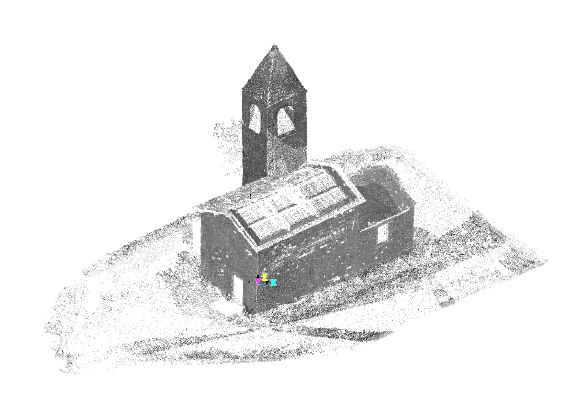
Figure 1: View of the point cloud of a small Church